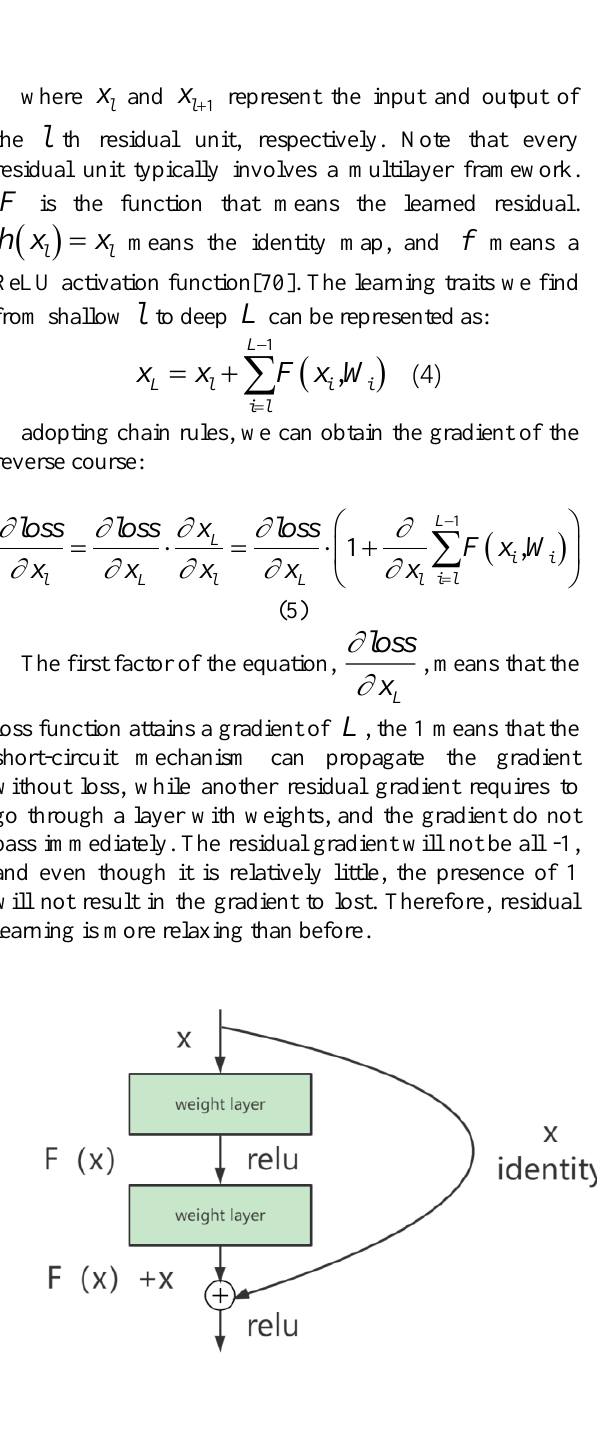
Figure 8. Residual module